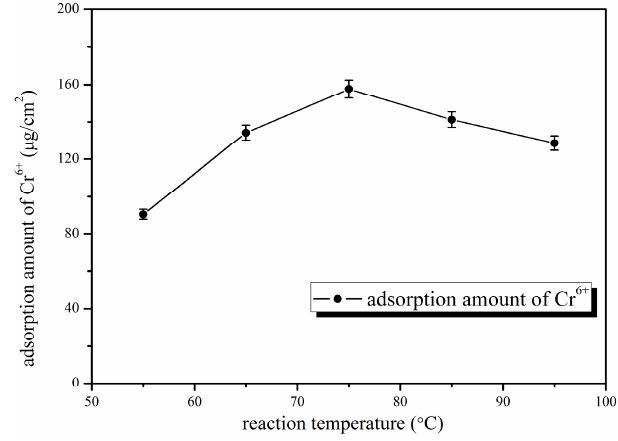
Figure 6. Effect of blending temperature on adsorption amount of Cr 6+ .